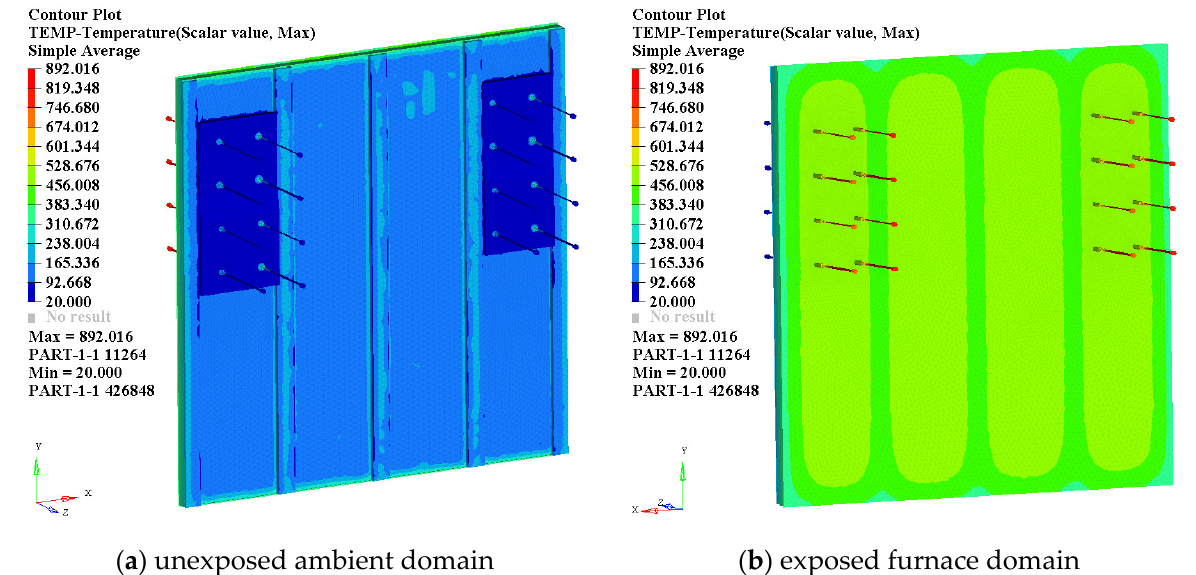
Figure 6. Temperature distribution contour results (unit: °C).